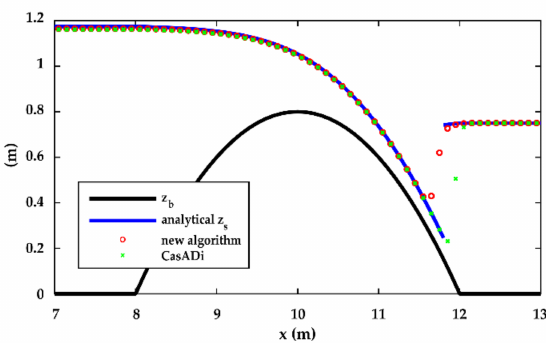
Figure 3. Comparison between the analytical solution and the numerical results produced by the new algorithm and CasADi for validation test A.